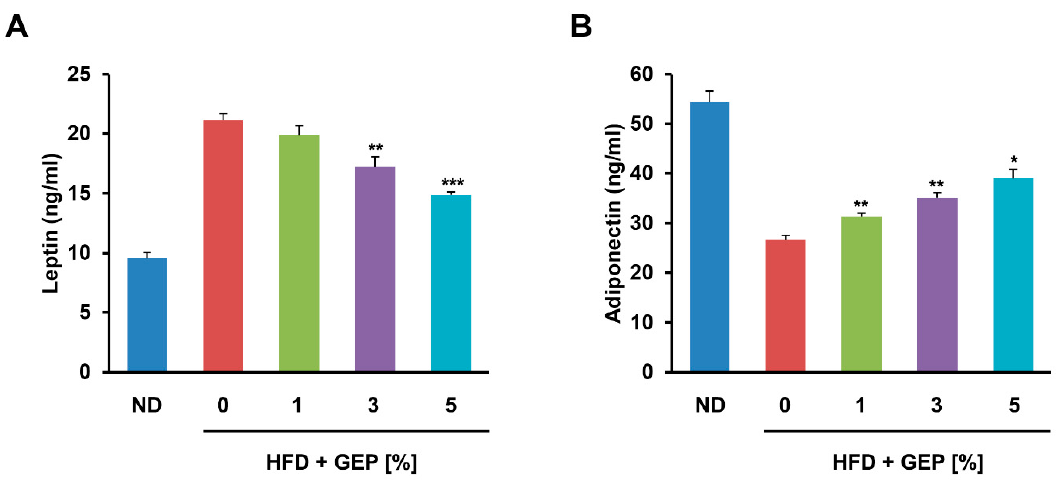
Figure 5. GEP treatment restored the regulation of the adipokines ( A ) leptin and ( B ) adiponectin. Data represent the mean ± SD of six to seven individual mice. Significant differences vs. the HFD group (control) were determined by one-way ANOVA; * p < 0.1, ** p < 0.01, *** p < 0.001. ND: normal chow diet group; HFD: high-fat diet group; HFD + GEP: high-fat diet and Ganoderma lucidum extract powder.